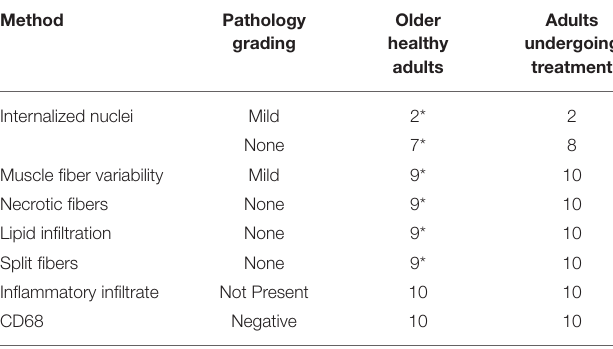
TABLE 4 | The results of histological analyses of rectus femoris biopsies.